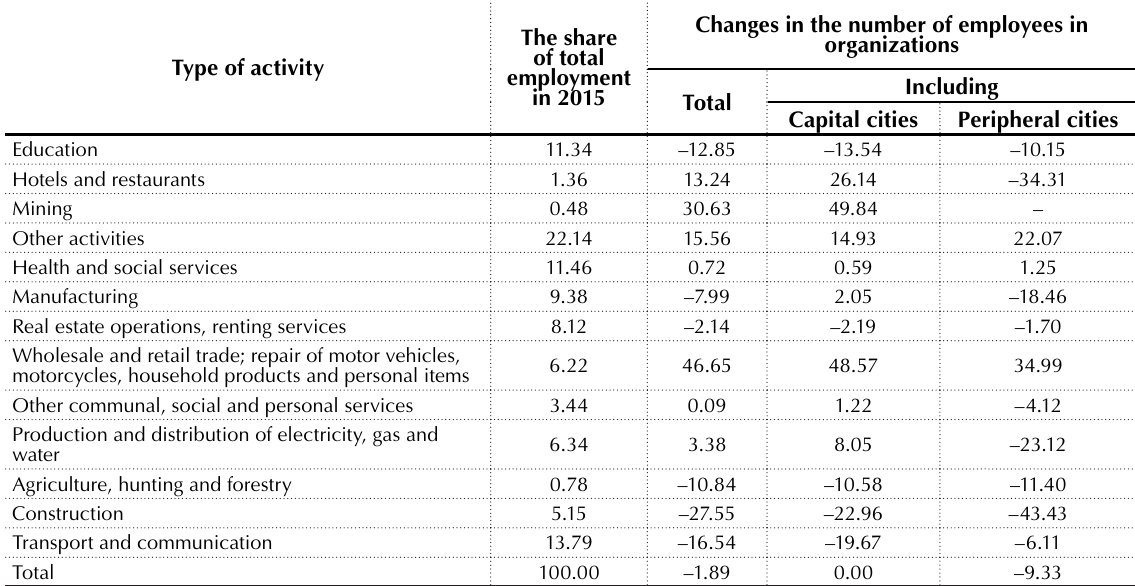
Table 7. Changes in the number of employees in organizations in cities of the Far Eastern Federal District, 2009–2015,